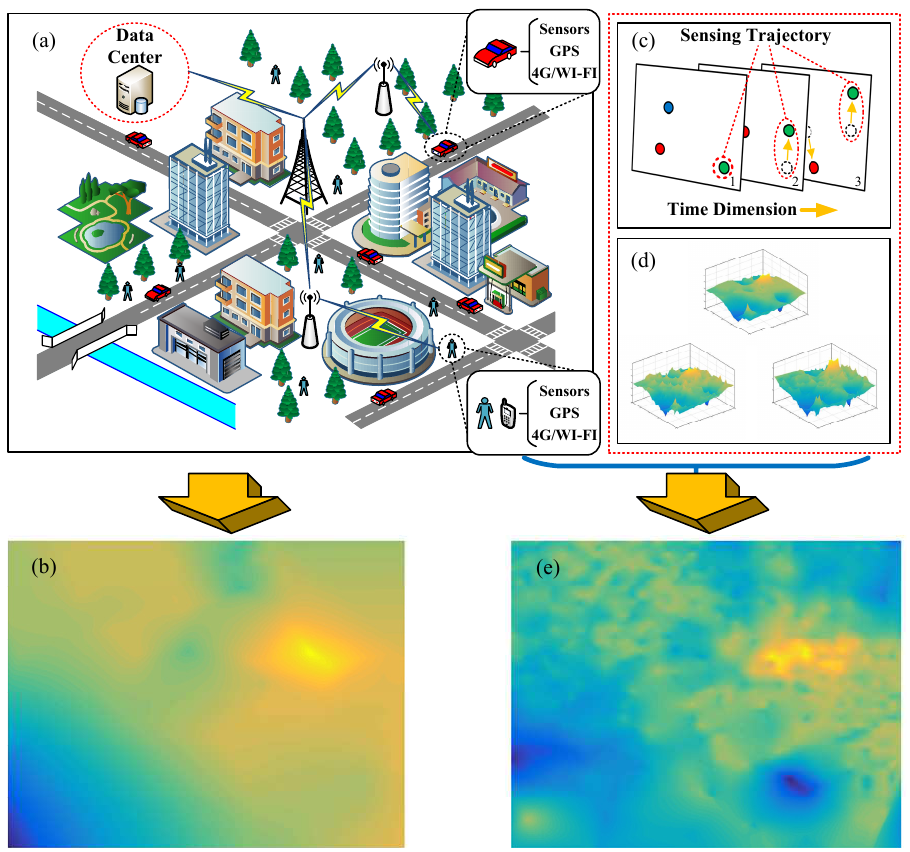
Figure 1. Crowdsensing networks based urban environment monitoring. ( a ) The crowdsensing networks, consisting of vast smartphones/vehicles, work as an urban camera; ( b ) Sensing image of target phenomenon generated by the crowdsensing network via interpolation method; ( c ) Sensing trajectories; ( d ) Correlated signals; ( e ) Sensing image after using enhanced crowdsensing